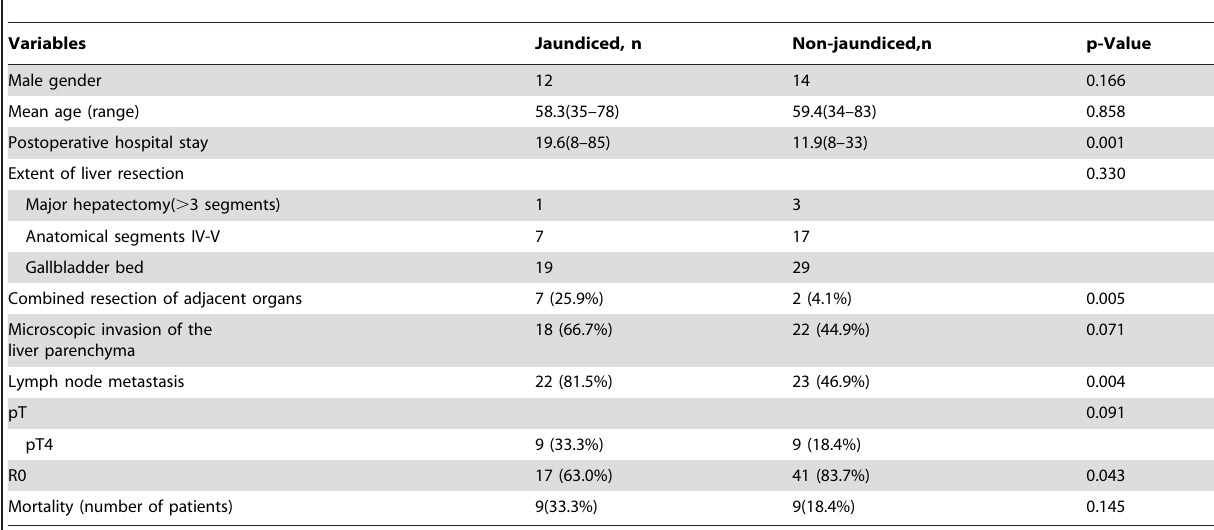
Table 6. Demographic data of jaundiced (n=27) and non-jaundiced patients (n=49) with gallbladder cancer.